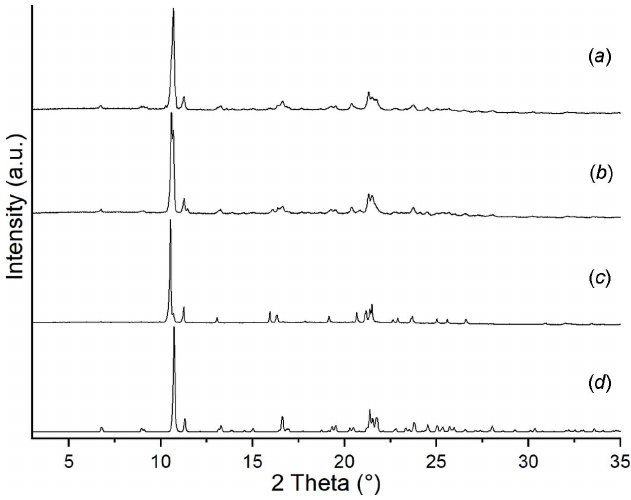
Figure 1 Experimental X-ray powder patterns of ( a ) [Ni(NCS) 2 (3-methyl- pyridine) 4 ] (cid:3) 2acetonitrile, ( b ) [Ni(NCS) 2 (3-methylpyridine) 4 ] (cid:3) 2ethanol, ( c ) [Ni(NCS) 2 (3-methylpyridine) 4 ] (cid:3) diethyl ether, each after 2 h in air, and ( d ) the calculated pattern of the title